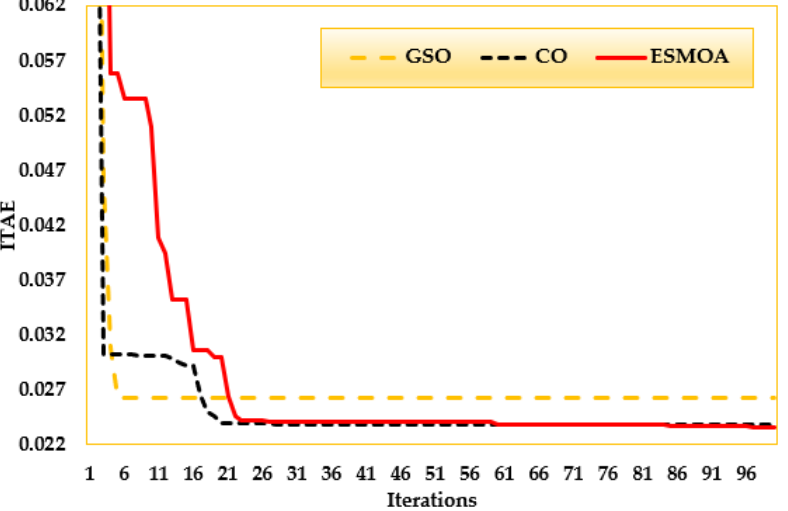
Figure 8. Converging characteristics of the suggested ESMOA, GSO, and CO techniques for Case 2. Table 5. Results for Case 2.